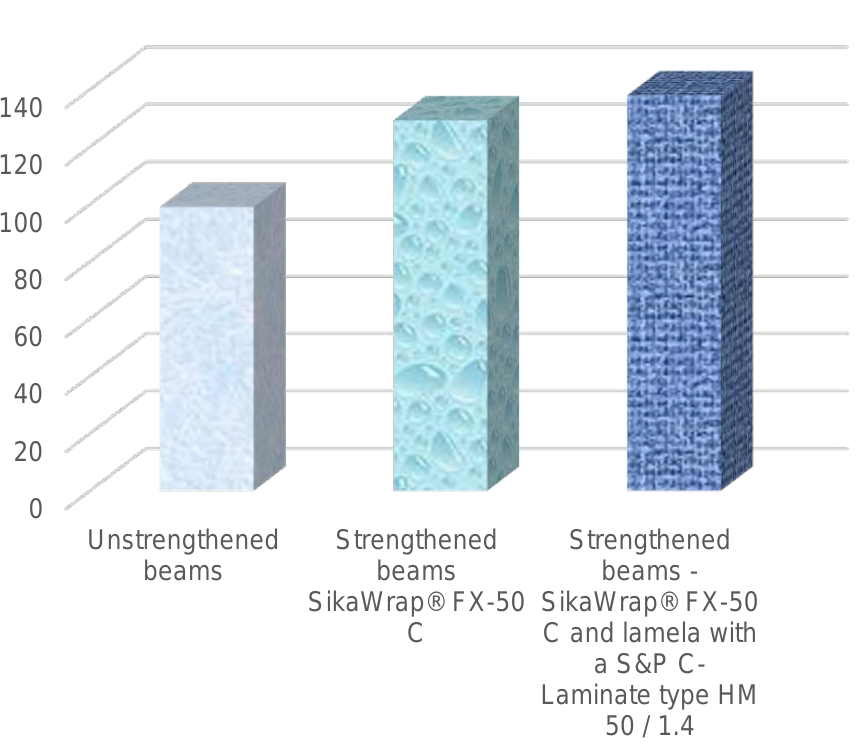
Figure 5. Bending strength diagrams of the strengthened and reference beams. carbon fibre SikaWrap ® FX-50 C increased by 35.58% or with SikaWrap ® FX-50 C and S&P C-Laminate type HM 50/1.4 carbon fibre CFRP by 45.42% with the reference beams. It was found that the displacement volume with the SikaWrap ® FX-50 C reinforced beam increased by 15.22% and with the SikaWrap ® FX-50 C reinforced beam and S&P C-Laminate type HM 50/1.4 CFK carbon fibre CFRP laminates by 19.49%, compared to the reference beams. After analysing Figures 4 and 5, it was found that beams reinforced with SikaWrap ® FX-50 C carbon fibre–carbon ropes, had a flexural strength (129.22 MPa) and modulus of elasticity (13,910 MPa), while beams reinforced with SikaWrap ® FX-50 C and S&P C- Laminate type HM 50/1.4 had a flexural strength (137.97 MPa) and modulus of elasticity (14,920 MPa). It was found that the flexural strength value of the reinforced SikaWrap ® FX-50 C beam increased by 31.53%, SikaWrap ® FX-50 C and S&P C-Laminate type HM 50/1.4 by 39.36%, whereas the modulus of elasticity of the SikaWrap ® FX-50 C increased by 35.58%, and SikaWrap ® FX-50 C I laminate S&P C-Laminate type HM 50/1.4 by